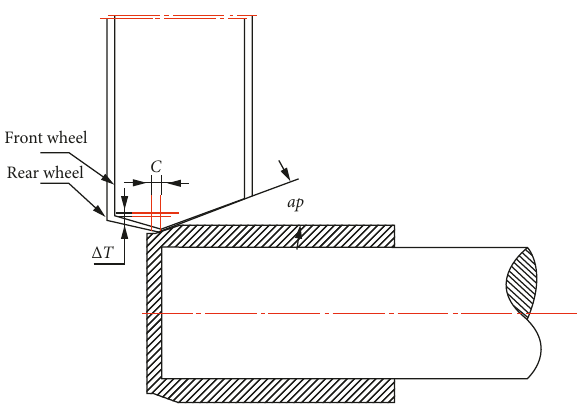
Figure 3: Offset analysis of the